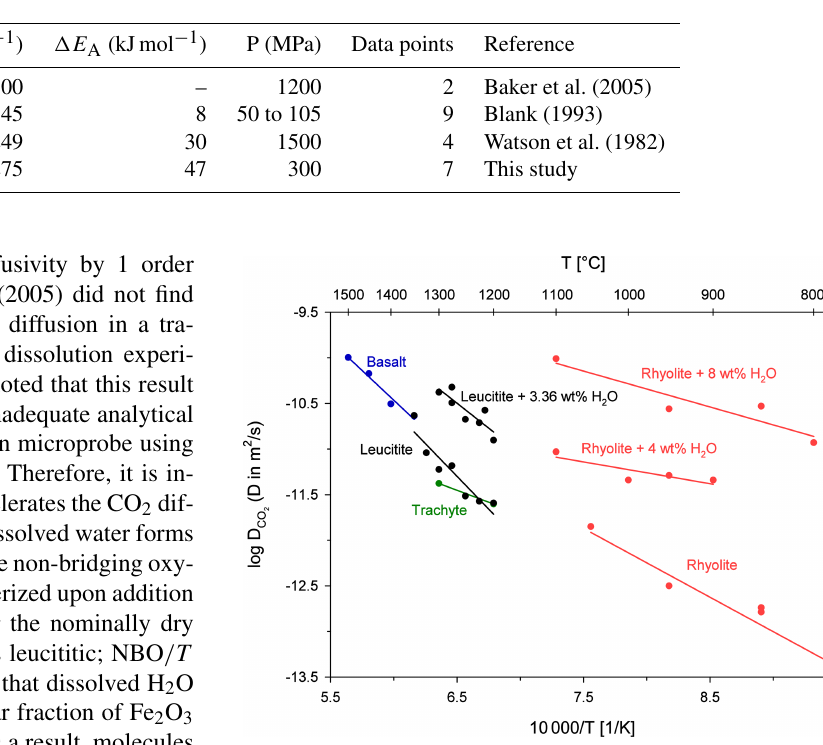
Figure 7. Arrhenius diagram for CO 2 diffusion in natural melts; rhyolite and H 2 O from Watson (1991); rhyolite from Blank (1993); basalt from Watson et al. (1982); trachyte from Baker et al.